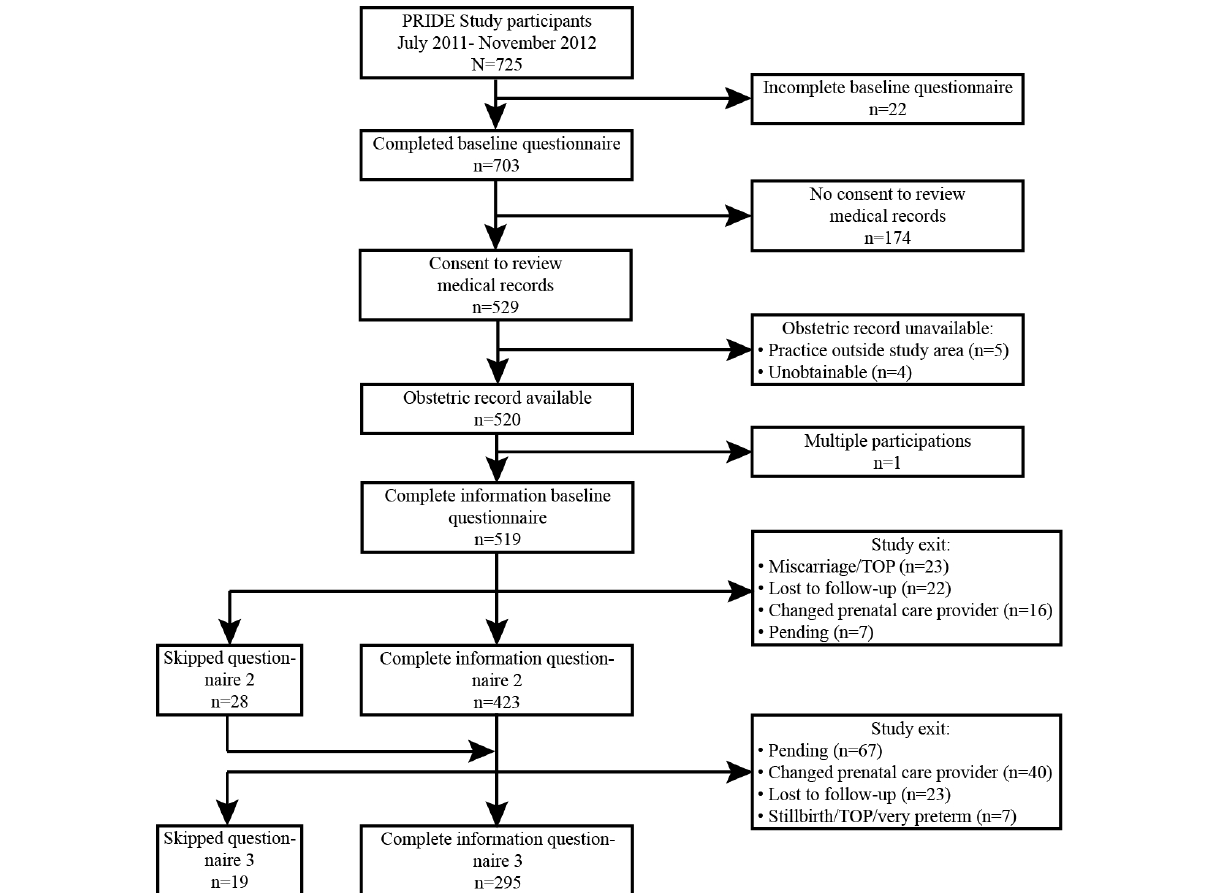
Figure 2. Flow chart of study